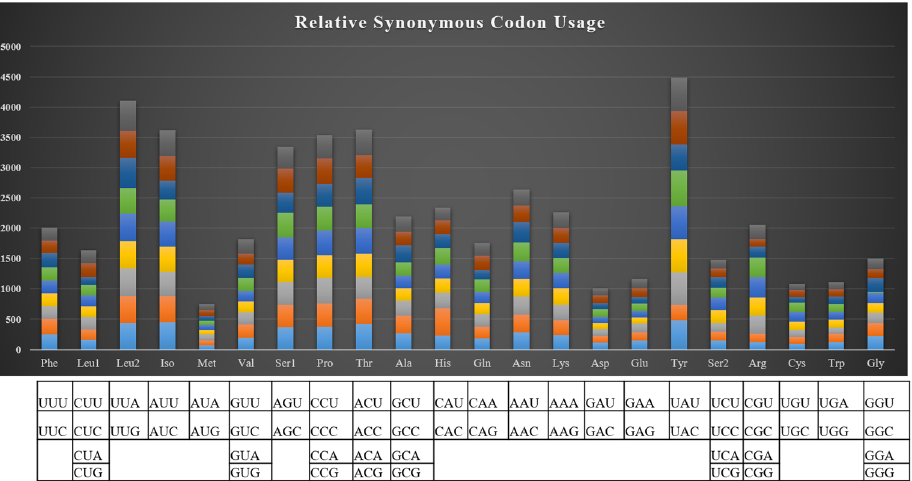
Figure 4. Codon usage of the mitochondrial protein coding genes of Asiatic black bear and other nine sub-species in Ursidae family (MH281753- Ursus thibetanus laniger, EF667005- Ursus thibetanus ussuricus , DQ402478- Ursus thibetanus mupinensis , EF587265- Ursus thibetanus thibetanus, EF076773- Ursus thibetanus formosanus , AF303109- Ursus americanus , MG066704- Ursus thibetanus, AB863014- Ursus thibetanus japonicus ; MN935768- Ursus thibetanus laniger (India; Present Study) .